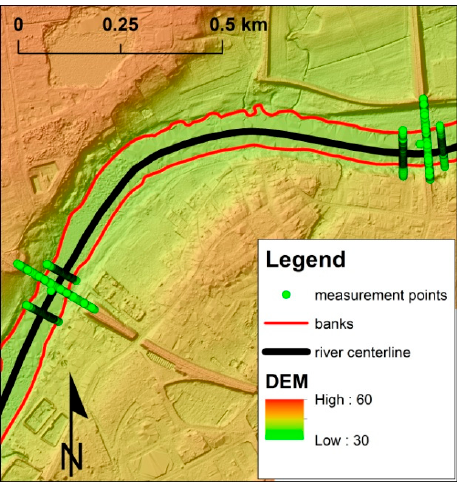
Figure 3. Example of required data: digital elevation model (DEM), polyline layers (river centerline, banks), and measurement points.